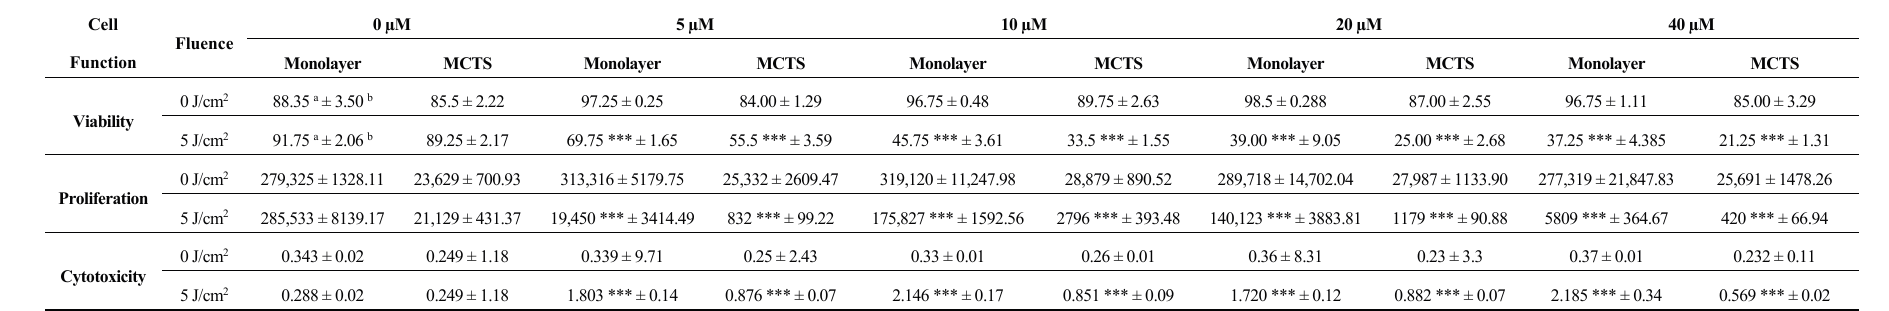
Table 1. Dose response of multicellular tumour spheroids (MCTS) (500 µm) treated with ZnPcS mix at various concentrations (0, 5, 10, 20 and 40 μ M) and irradiated using 0 or 5 J/cm 2 . Trypan blue was used to determine percentage viability, while adenosine triphosphate (ATP) was used to measure cell proliferation and luminescence was recorded as relative light units (RLU). Cytotoxicity was determined using lactate dehydrogenase (LDH) assay and absorbance was measured at 490 nm. Statistical differences between untreated controls and the experimental groups are shown as *** p < 0.001. Experiments were repeated four times ( n = 4). a Mean; b Standard